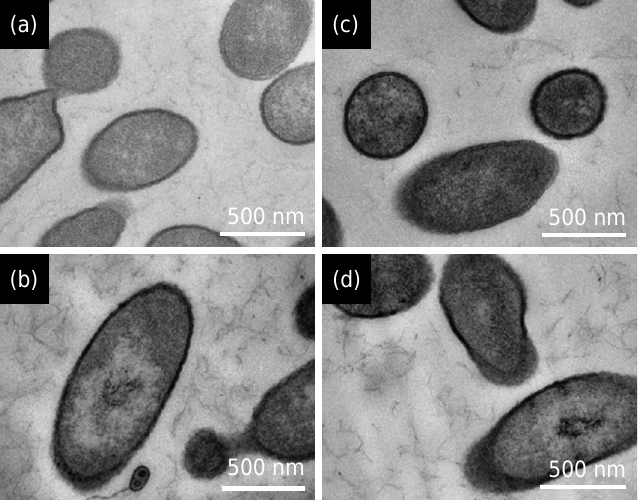
Figure 5. Transmission electron micrograph of the C. necator strain UFLA 01-659 cultured in liquid LB medium in the following treatments: control - absence of metals (a), Cd at 1 mmol L -1 (b), Cu at 2 mmol L -1 (c), and Zn at 2 mmol L -1 (d). Arrows indicate the locations of clearest contrasts of metal